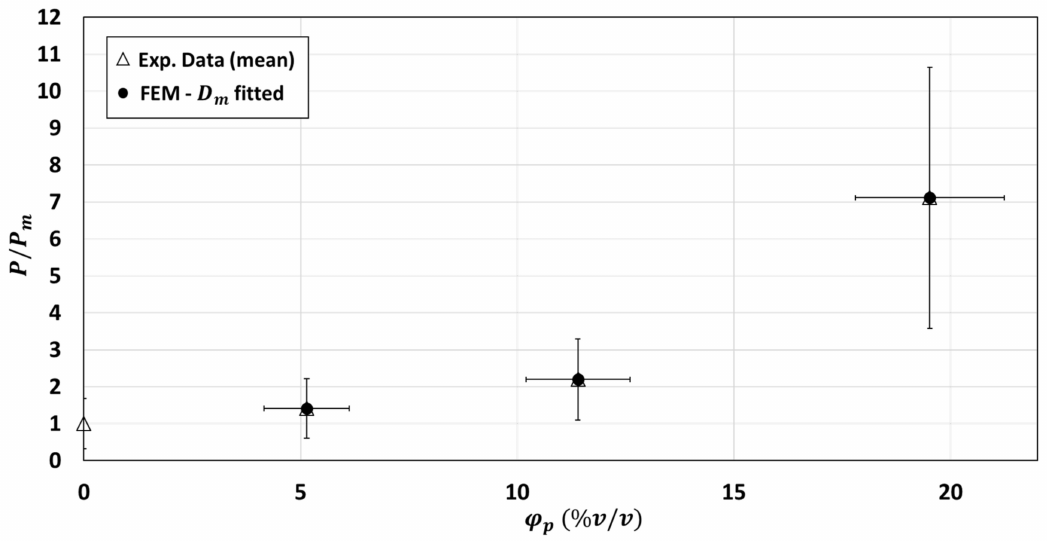
Figure 10. Comparison between experimental and numerical relative permeability P / P m (calculated using the 2-phase model): adjustment of numerical model to experimental data by fitting the matrix diffusivity D m (fitting performed on 10 structures for each